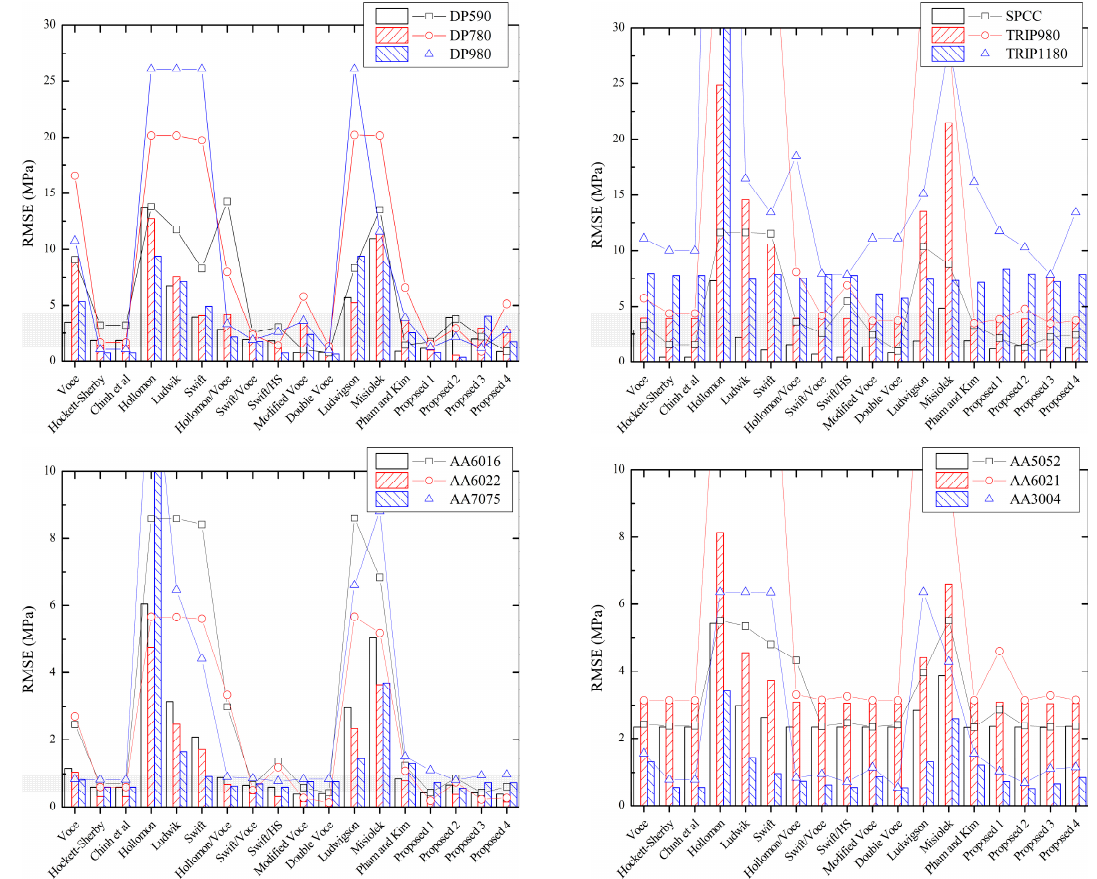
Figure 5. RMSE of the identified hardening laws for tested materials. Column charts indicate the results of the common curve fitting method; opened symbols indicate the results of the constrained curve fitting method.